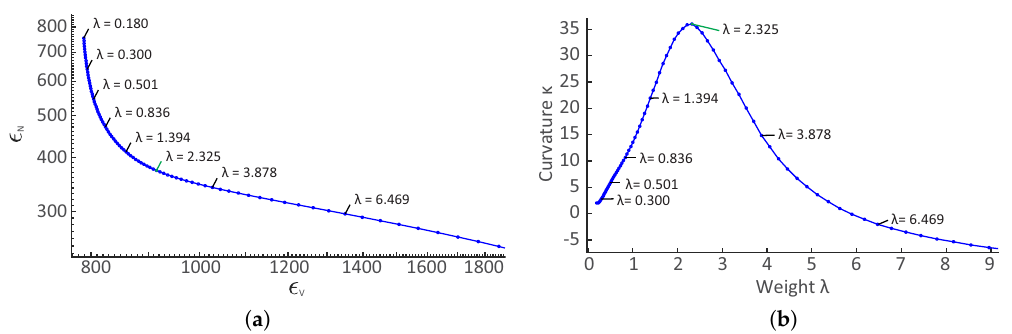
Figure 14. ( a ) L-Curve for FPA dataset. ( b ) Curvature of L-Curve (shown on a smaller segment of weights for bigger clarity).